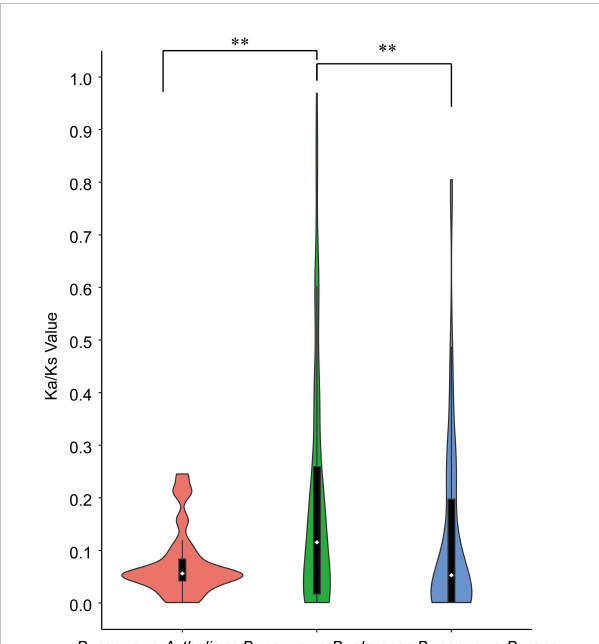
FIGURE 5 Violinplot of the pairwise Ka/Ks ratios of syntenic orthologous gene pairs. Only orthologous gene pairs with Ks <1 were considered. Wilcoxon Rank-Sum Tests were performed between different types of orthologous gene groups (**P < 0.01). Dotted lines within the violin plots represented the fi rst, second, and third